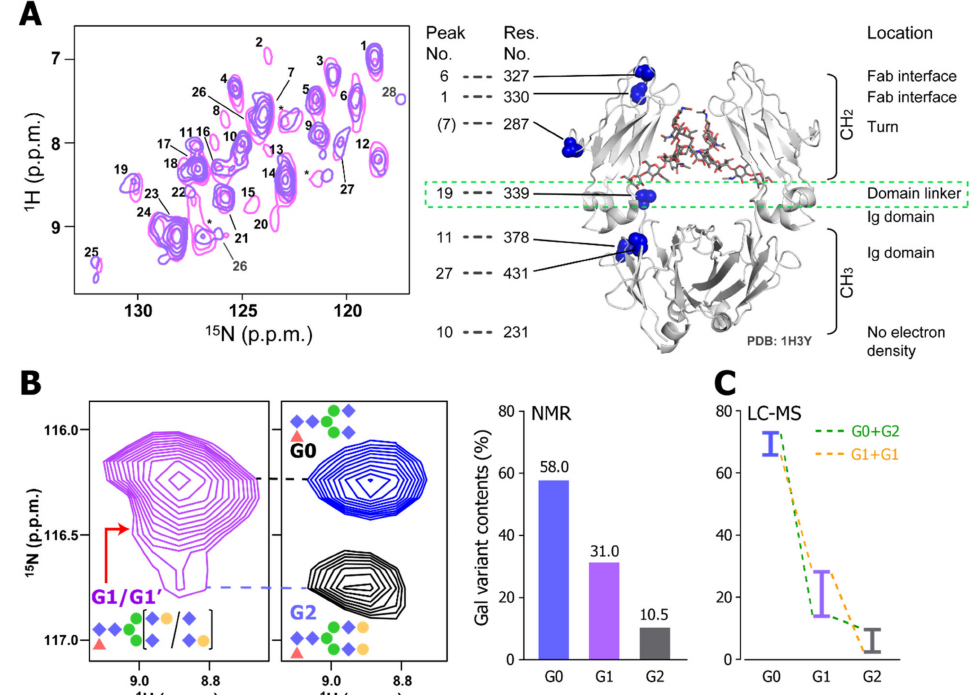
Figure 4. The HOS analysis of a mAb using a 15 N-detected CRINEPT experiment. ( A ) Overlaid 15 N-detected CRINEPT spectra of [ 15 N-Ala] mAb in SC (pink) and IV (blue) formulations. The as- signments are based on the chemical shifts of the Ala resonances of the Fc fragment. as previously reported [51]. The structure of the Fc fragment (1H3Y) [72] is shown along with the positions of Ala residues. Signals from 15 N TROSY components are labeled with numbers. ( B ) The heterogeneity of the galactosylation states analyzed by the 15 N-detected CRINEPT experiment. Left: the 1 H– 15 N resonance of Lys-248 in the 15 N-detected CRINEPT spectrum of the intact mAb is shown along with those from the ∆ Gal (blue) and Gal (black) samples, which are enzymatically galactosidated and galactosylated, respectively. Right: ratios of different galactosylation states, estimated from the deconvolution of the Lys-248 resonance in the intact mAb. ( C ) Ratios of different galactosylation states by LC–MS analysis. Reflecting that the analysis cannot discriminate G0_G2 and G1_G1 states, each bar represents the upper and lower limits of the indicated population. The figure is reproduced from